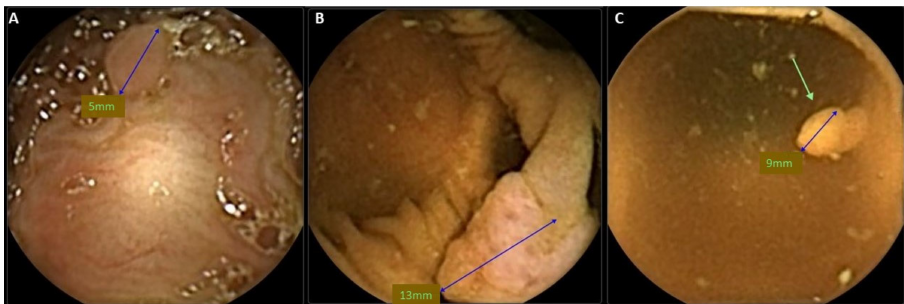
Figure 2. Colon polyps seen from colon capsule endoscopy. ( A ). Diminutive hyperplastic polyp, ( B ). 13-mm sessile polyp, and ( C ). small, pedunculated adenomatous